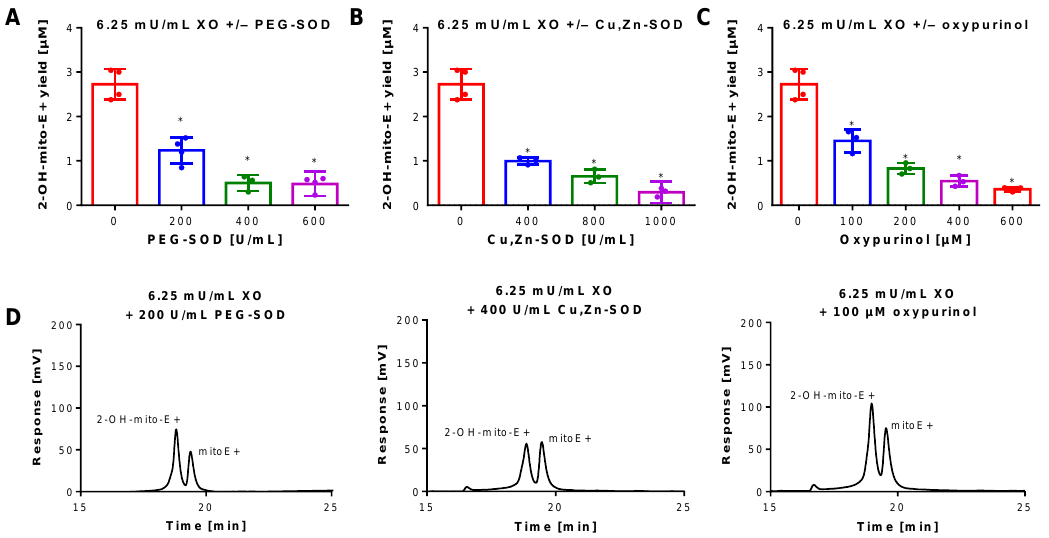
Figure 2. Inhibition of superoxide formation and detection by mitoSOX HPLC. An XO concentration of 6.25 mU/mL was chosen for continuous and sufficient superoxide formation. The yield of the superoxide-specific mitoSOX oxidation product 2-OH-mito-E+ was quantified in the presence of increasing concentrations of the superoxide scavenging enzymes PEG-SOD or native Cu, Zn-SOD ( A,B ) or the XO inhibitor oxypurinol ( C ). The reaction solution contained 0.1 M potassium phosphate buffer at pH 7.4 and 1 mM hypoxanthine and was incubated for 30 min at 37 °C. ( D ) Representative chromatograms are shown for the lowest inhibitor concentration. Data are mean ± SD of 3 – 4 independent experiments. * p < 0.05 vs. unstimulated control.